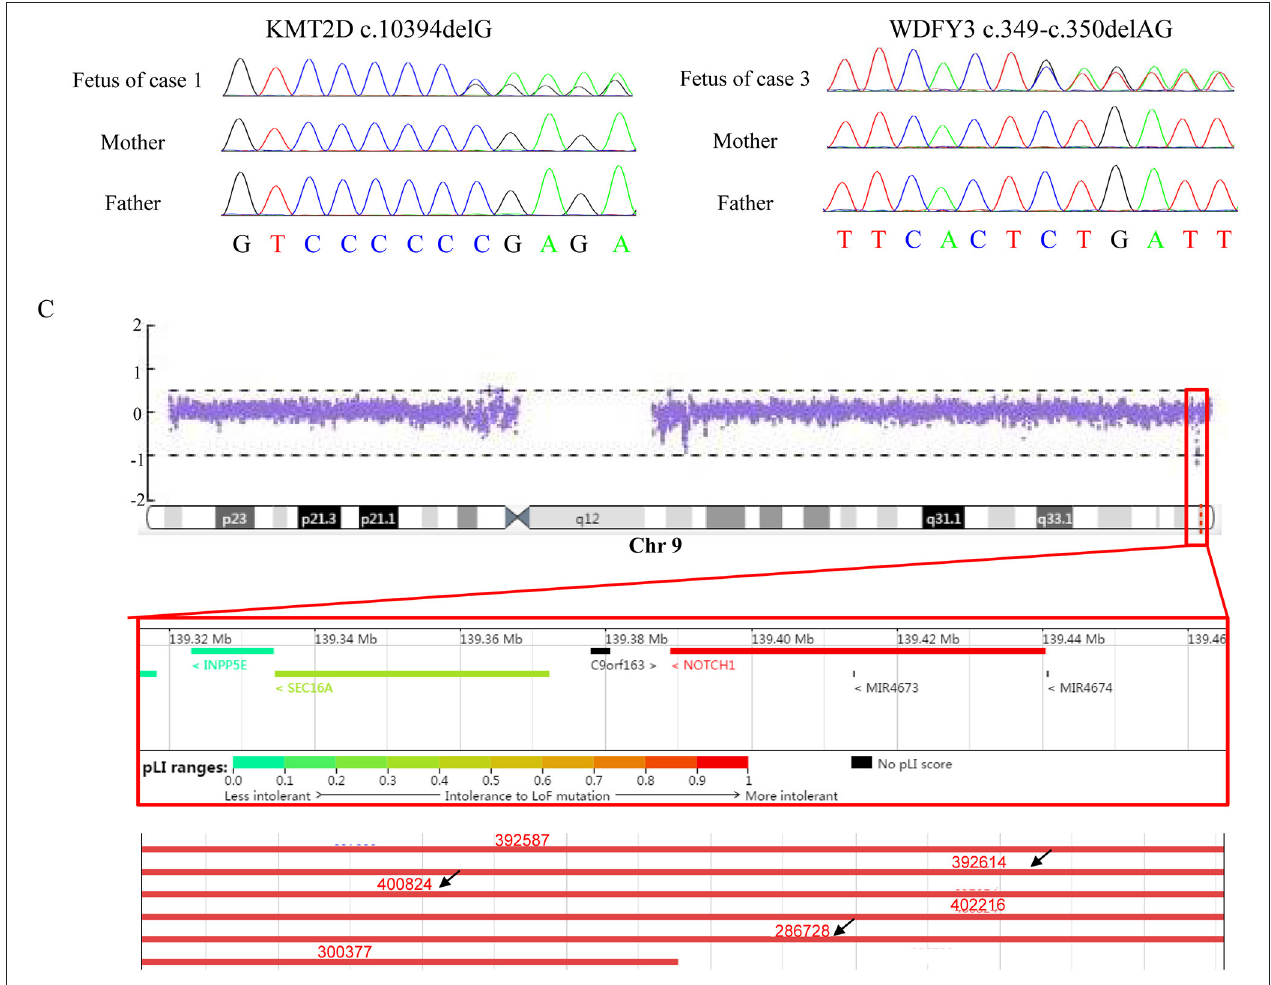
FIGURE 1 | Results of Sanger sequencing and CNV-seq. (A) The mutation, c.10394delG, identified in KMT2D in the fetus (case 1) but not in the parents. (B) The mutation, c.394-c.350delAG, found in WDFY3 in the fetus (case 3) but not in the parents. (C) A 150kb microdeletion at 9q34.3 resulting in deletion of full-length of NOTCH1 detected in case 2 and part of microdeletion variants encompassing the region in Decipher. Variants pointed by black arrow displayed heart